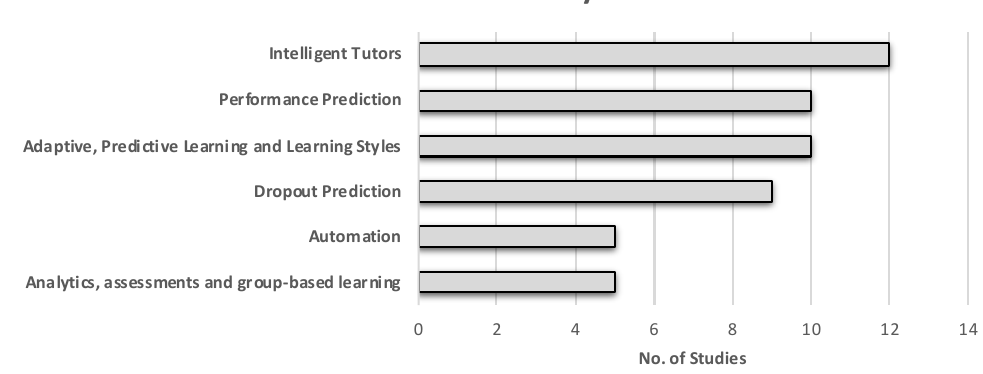
Figure 4. Classification of studies in thematic